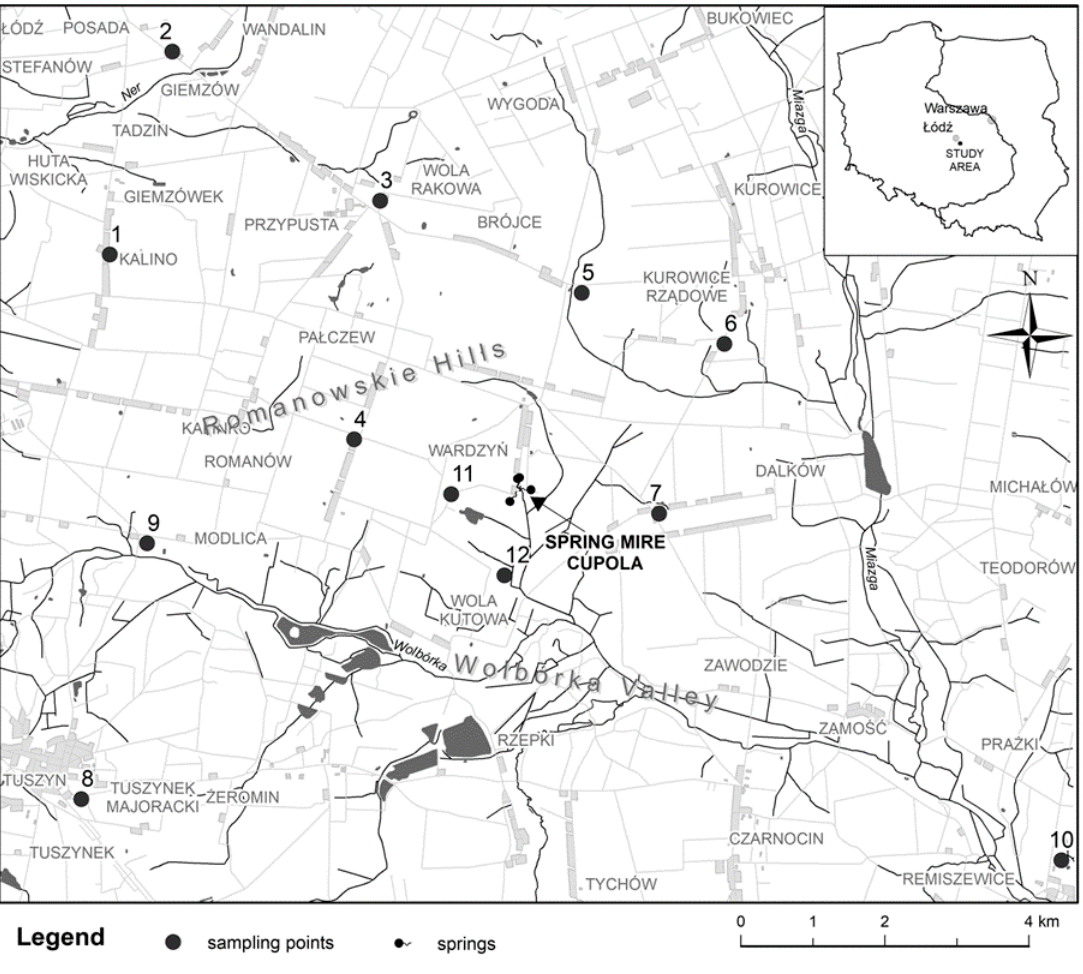
Figure 1. Location sketch-map.